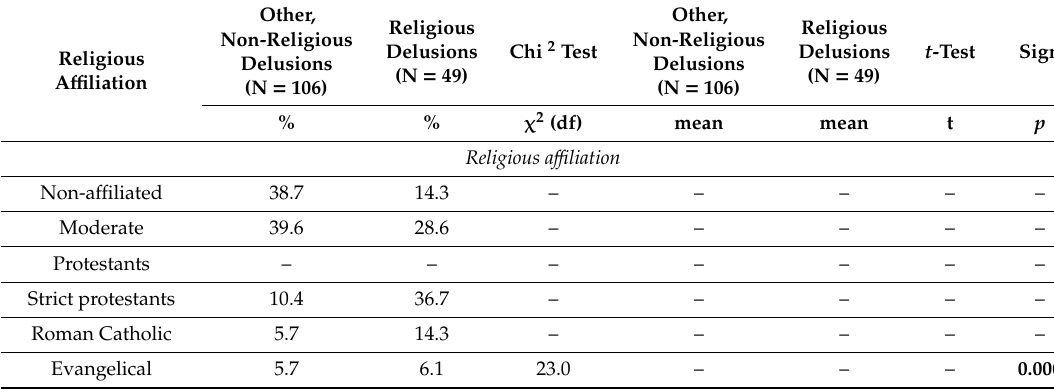
Table 6. Associations between the aspects of religiousness and RDs compared to the aspects